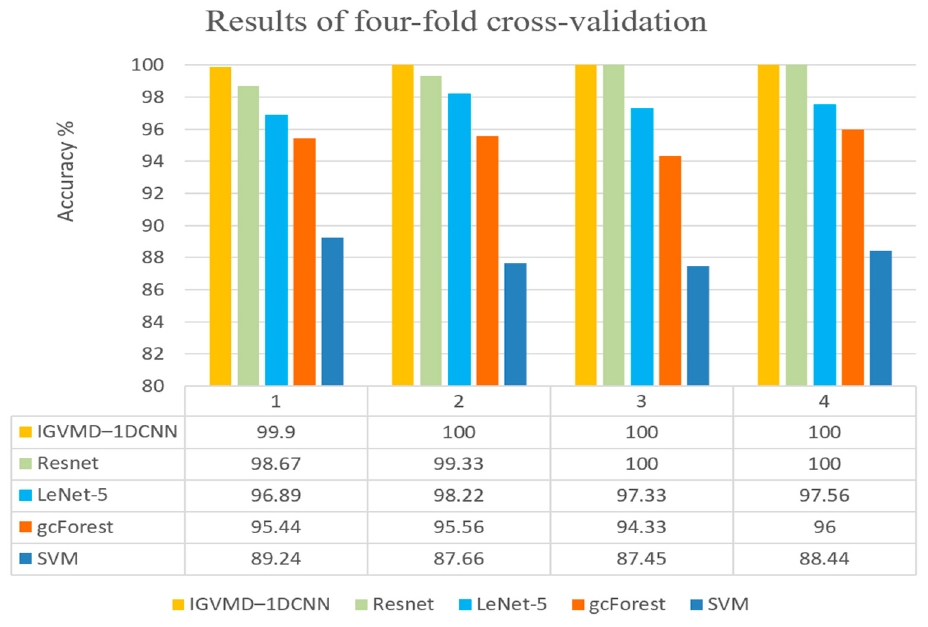
Figure 22. The cross-validation results of different models with CWRU. Table 8. Comparison results with the different models using the CWRU